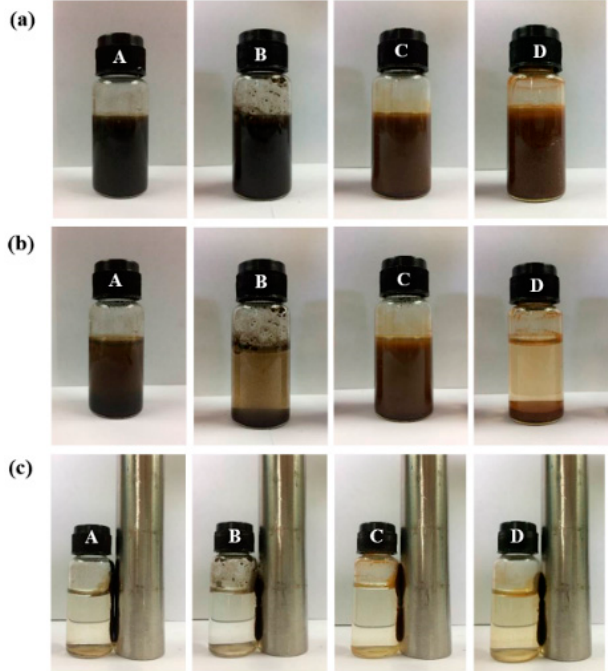
Figure 8. Dispersion property of the synthesized bare MnFe 2 O 4 (A), MnFe 2 O 4 _1.2CMC_SDS (B), Fe 0.8 Mn 0.2 Fe 2 O 4 _1.2CMC_SDS (C), Fe 3 O 4 _1.2CMC_SDS ferrite nanoparticles (D): ( a ) after ultrasoni- cation; ( b ) 15 min; ( c ) under applied an external magnetic field.